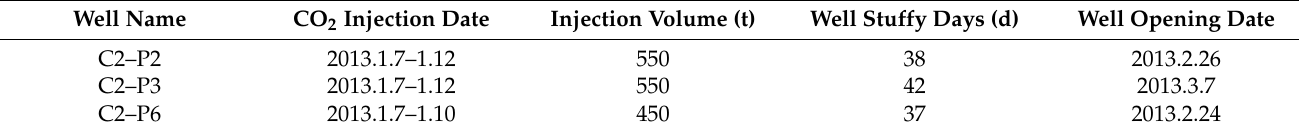
Table 10. Synergistic throughput implementation plan.